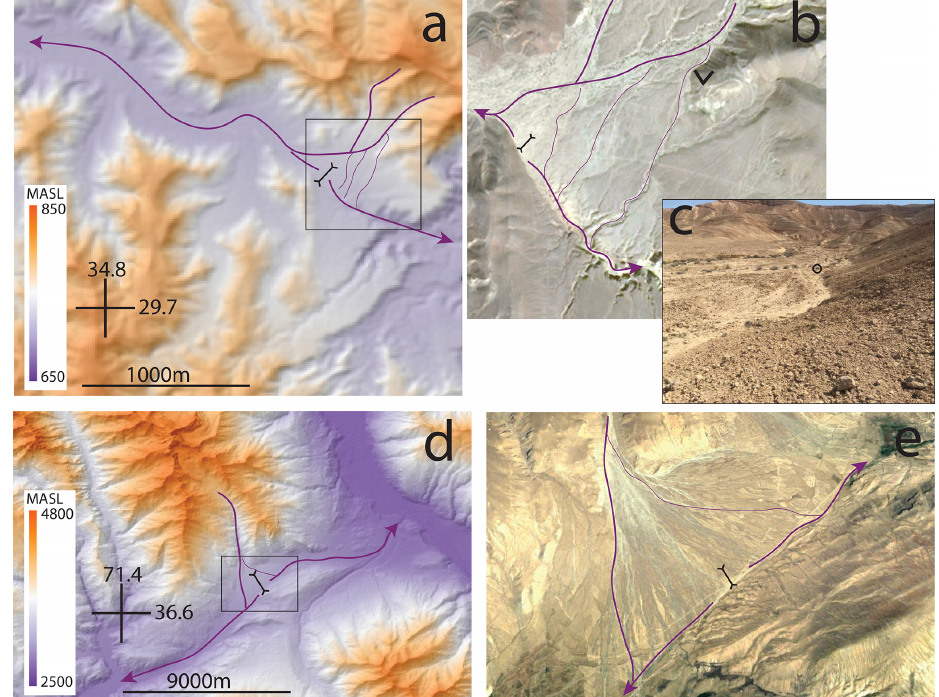
Figure 4. Examples of avulsions across wind gaps (forked black line). Channels are marked in purple. (a) A map based on a TanDEM-X DEM (Krieger et al., 2007) of a wind gap next to Mt. Berech in the Negev highlands along the Arava escarpment, Israel. Note that although the side tributaries drain primarily northwest of the wind gap, a few bifurcating branches appear to route a fraction of the tributaries’ discharge to the other side of the wind gap. The black box marks the area shown in panel (b) . (b) An air photo (© Google Earth 2020) showing the main channels of the side tributaries as well as their bifurcating branches. A black v-shaped symbol open to the north shows the locations from which the picture in panel (c) were taken. (c) View of an avulsion point looking upstream (north) from the aforementioned v-shaped symbol. The circle marks a backpack for scale that is located at the bifurcation point. (d) A map based on a GMTED2010 DEM (Danielson and Gesch, 2011) of the Ishkashim Pass area in Afghanistan. Note that although the side tributary drains primarily southwest of the wind gap, a few bifurcating branches appear to route a fraction of its discharge to the other side of the wind gap. The black box marks the area shown in panel (e) . (e) An air photo (© Google Earth 2020) showing the bifurcation of a side tributary across the wind